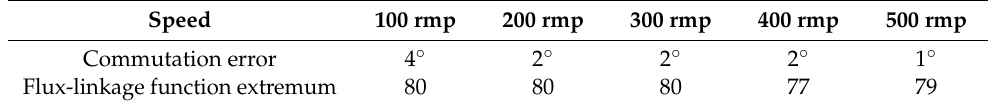
Table 4. Commutation error of the proposed